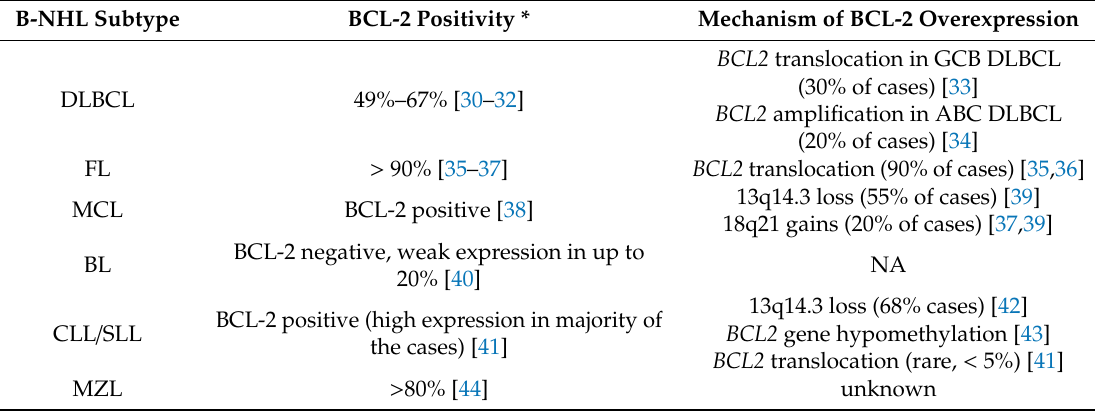
Table 1. Mechanisms of B-cell leukemia / lymphoma-2 (BCL-2) overexpression in B-cell non-Hodgkin lymphomas